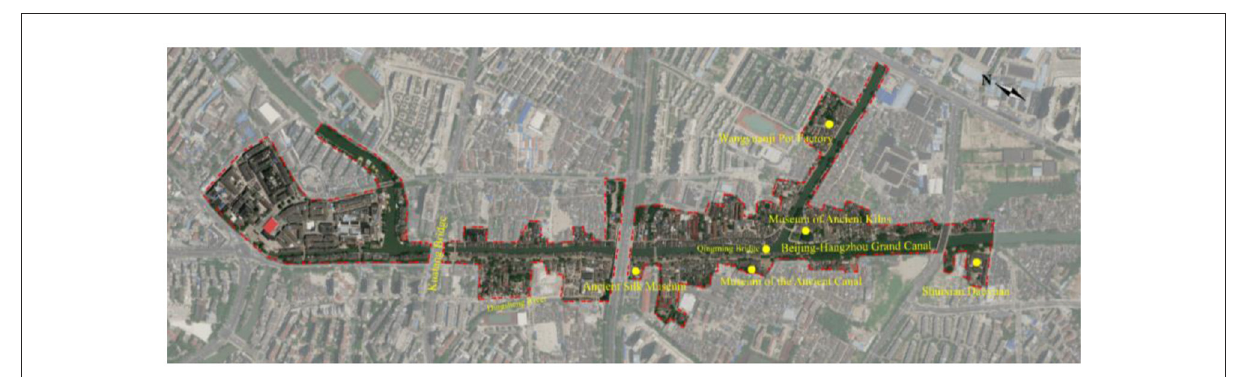
FIGURE2 Satellite map of Qingming Bridge historical and cultural